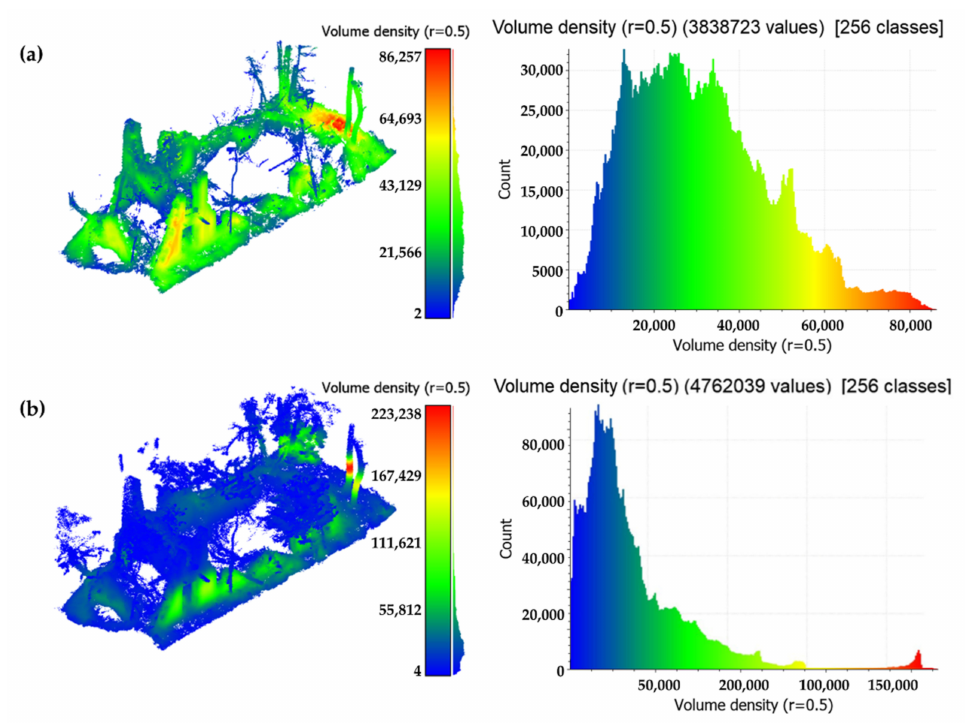
Figure 13. Point cloud density expressed in pts/m 3 of TLS data and relative histogram ( a ) with respect to Kaarta Stencil WMMS data ( b